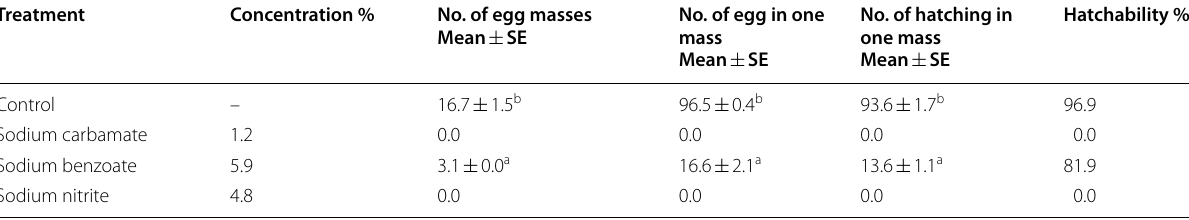
Table 2 Effect of ½ LC of three inorganic salts on egg product of land snail, Massylaea vermiculata 50